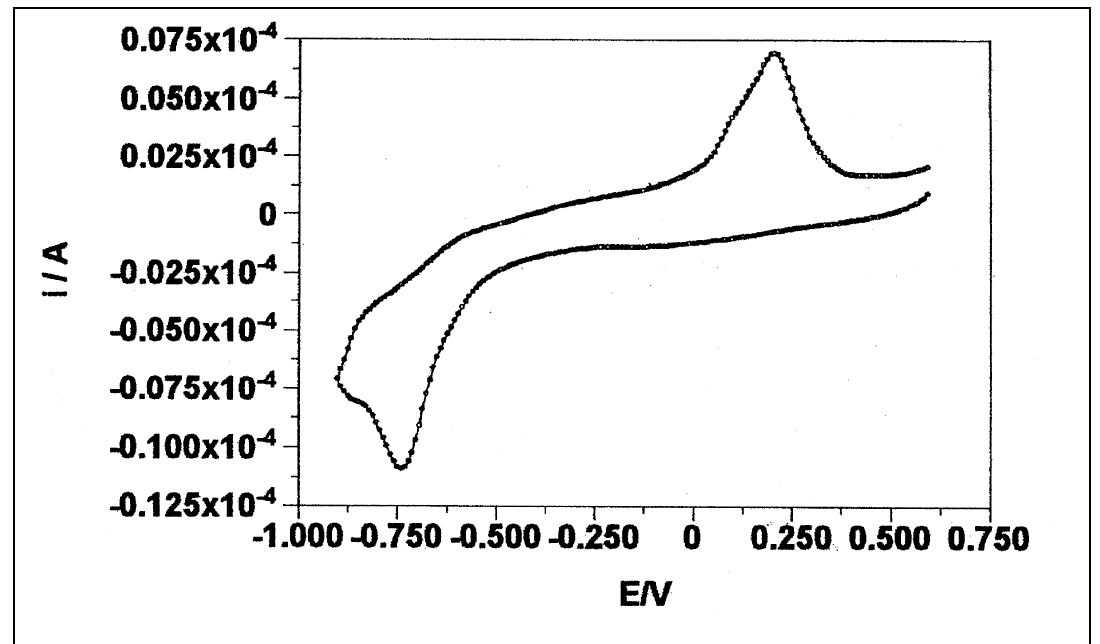
Figure C. Electrochemical behavior of the silver-cysteamine